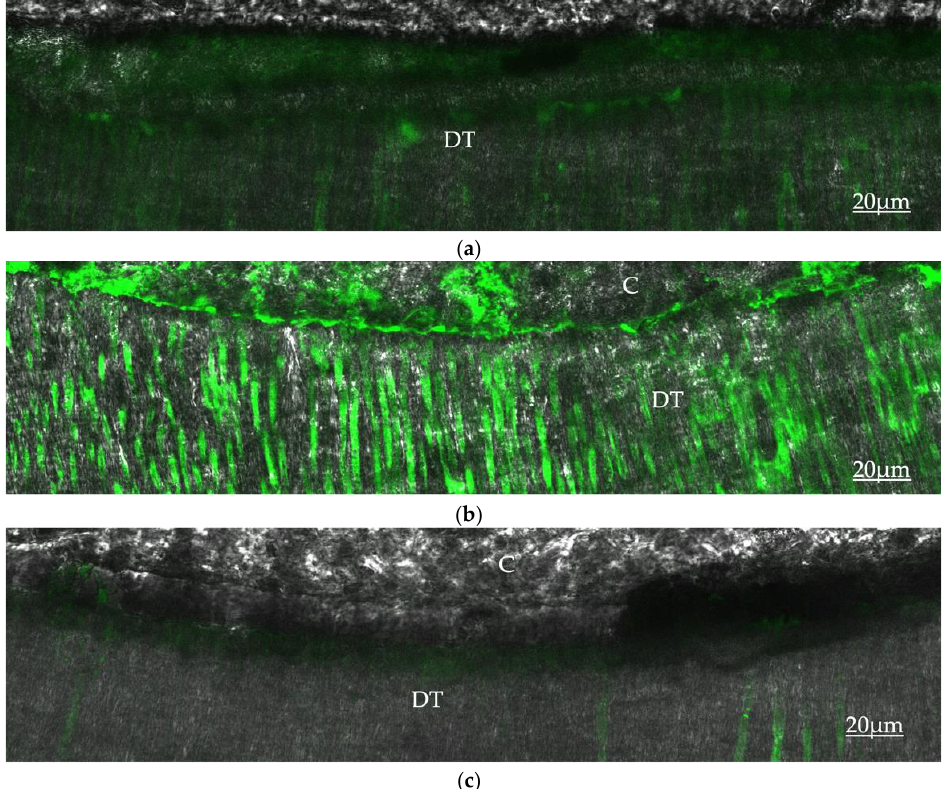
Figure 1. Multiphoton confocal microscopy in situ zymography images showing hydrolyzation activity of fluorescein-conjugated gelatin by the MMPs in dentine following the use of different irrigating solutions: ( a ) 5.25% Sodium hypochlorite; ( b ) 5.25% Sodium hypochlorite and 10% citric acid; ( c ) 5.25% Sodium hypochlorite, 10% citric acid, and 0.2% chlorhexidine. [DT: dentinal tubules; C: resin cement — Core X flow (Dentsply Sirona, Ballaigues, Switzerland)].